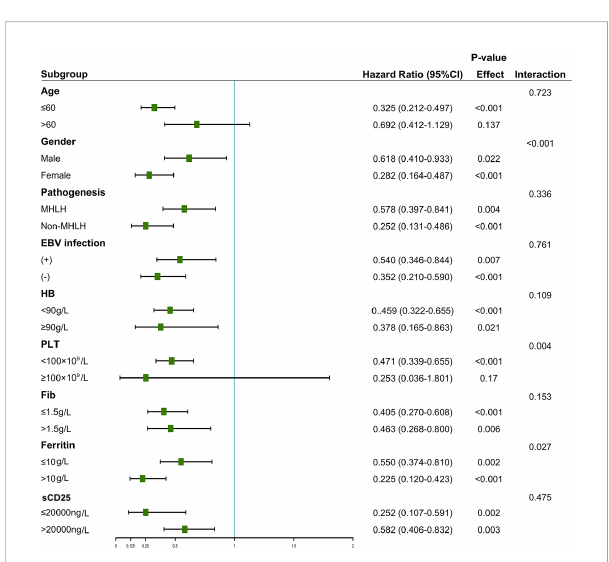
FIGURE 5 Strati fi ed associations between HDL-c and overall survival. A Cox proportional hazards model determined the hazard